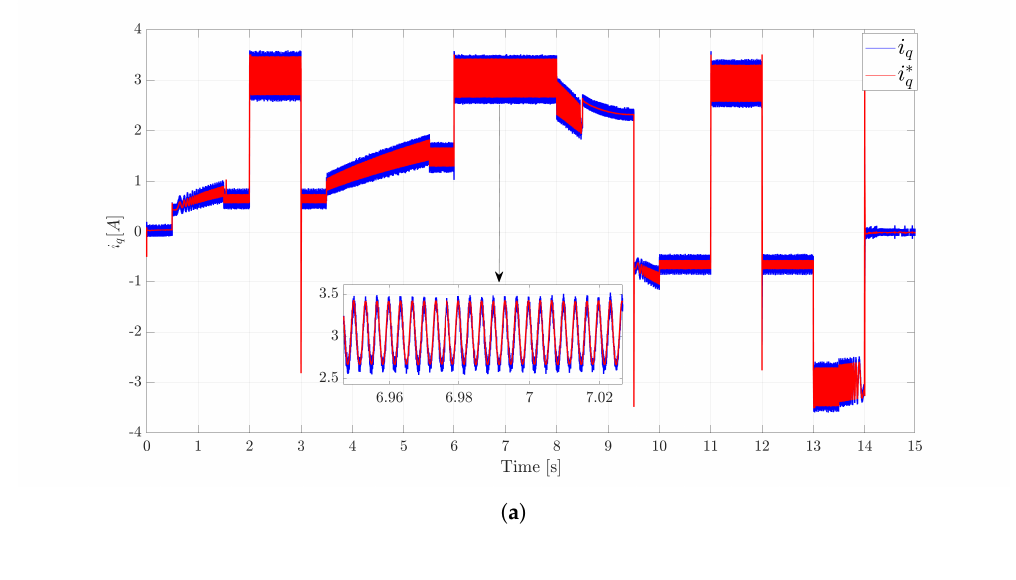
Table 2. Comparison of torque ripple rates for the three control modes. PI SMC STA ∆ T e Without Load With Load Without Load With Load Without Load With Load At 300 r.p.m 38.08% 9.8% 43% 10.07% 29% 5% At 1500 r.p.m 17.3%